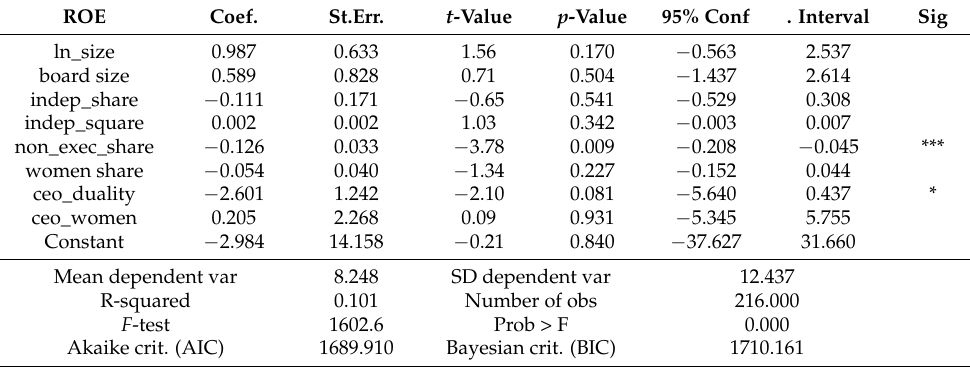
Table A2. Non-Linear Model with Board and CEO Characteristics. ROE